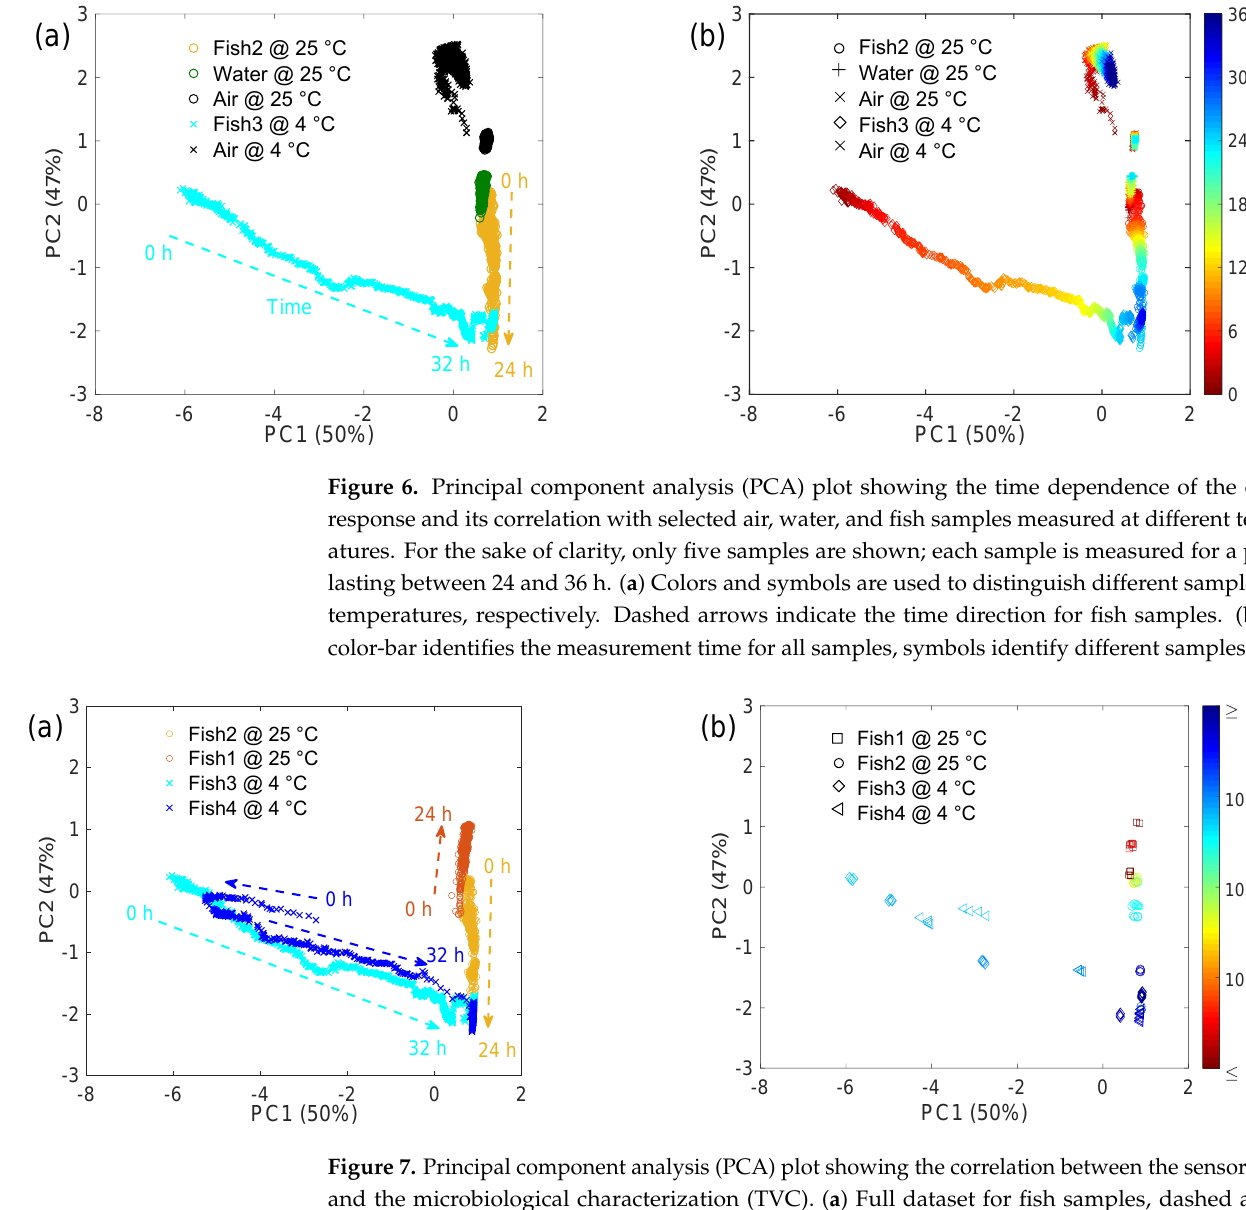
Figure 7. Principal component analysis (PCA) plot showing the correlation between the sensor signal and the microbiological characterization (TVC). ( a ) Full dataset for fish samples, dashed ar- rows indicate the time direction for each sample. ( b ) Subsample data (see text for details) showing the correlation between the score plot and the respective total viable count (TVC).